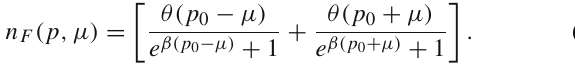
a neutral current and gives a nonzero contribution for an asymmetric combination of an electron–positron background only. The bubble dia- gram ( c ) gives a major contribution to the magnetic dipole moment of the